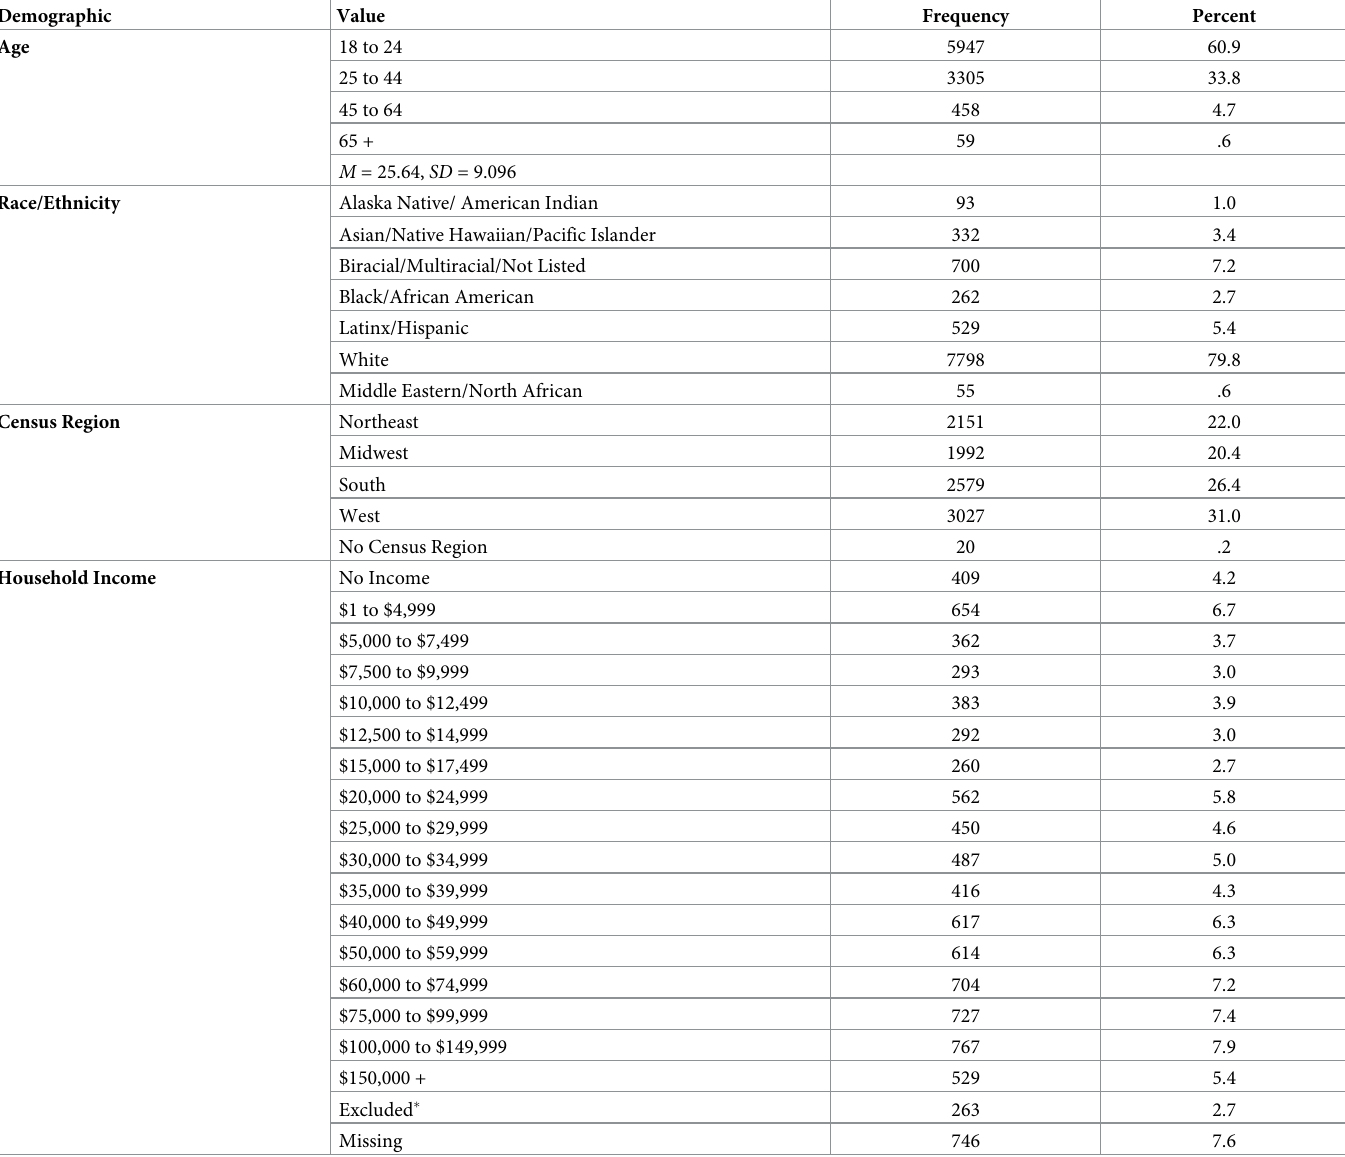
Table 1. Demographic characteristics of the